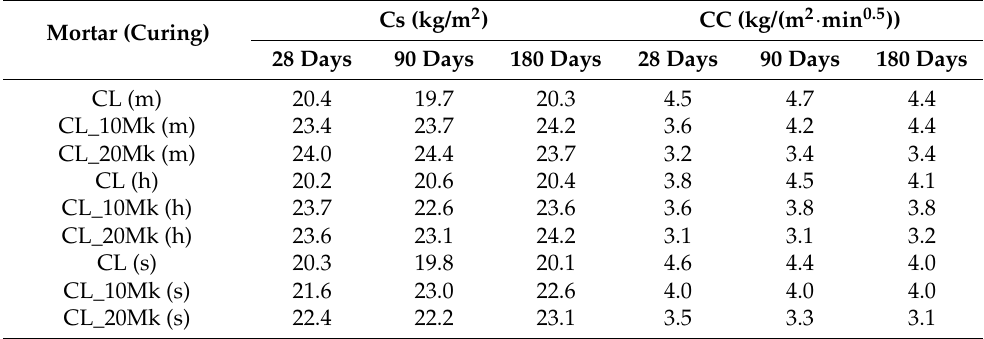
Table 5. Capillary saturation value (Cs) and capillary coefficient (CC) of mortars with 0, 10 and 20% Mk replacing air lime, after 28, 90 and 180 days in maritime, humid and standard curing conditions. Mortar